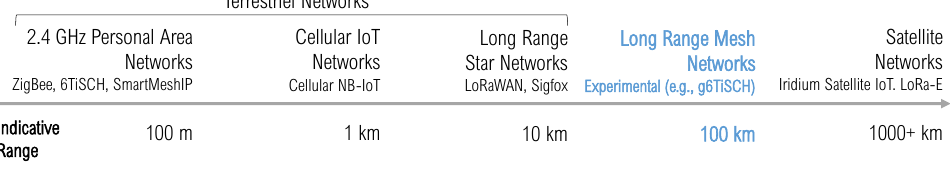
Figure 3. Existing low-power wireless technologies and their indicative